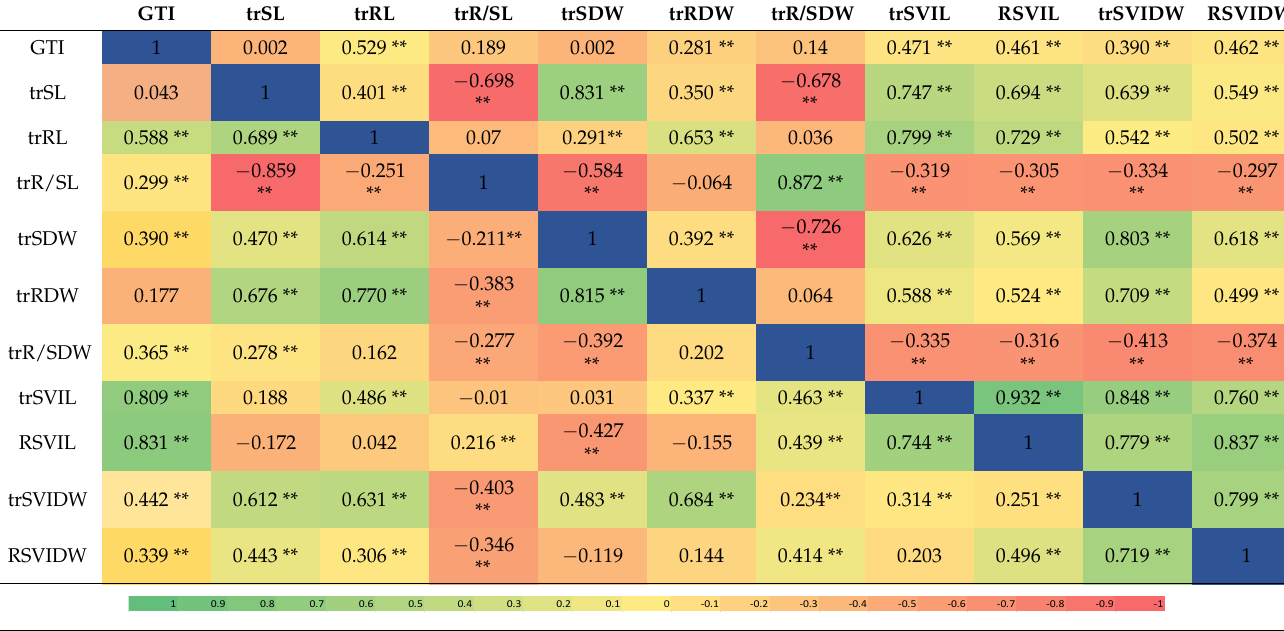
Table 2. Pearson correlation among seedling survival traits of diverse barley panel (above) and CM72/Gairdner DH (below main diagonal) in 150 mM NaCl.